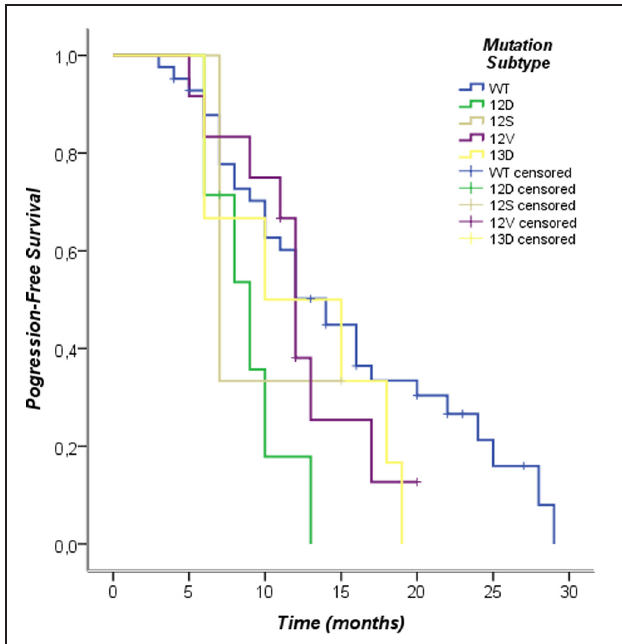
FIGURE 4 | Kaplan–Meier curves of overall survival according to KRAS mutation pattern.